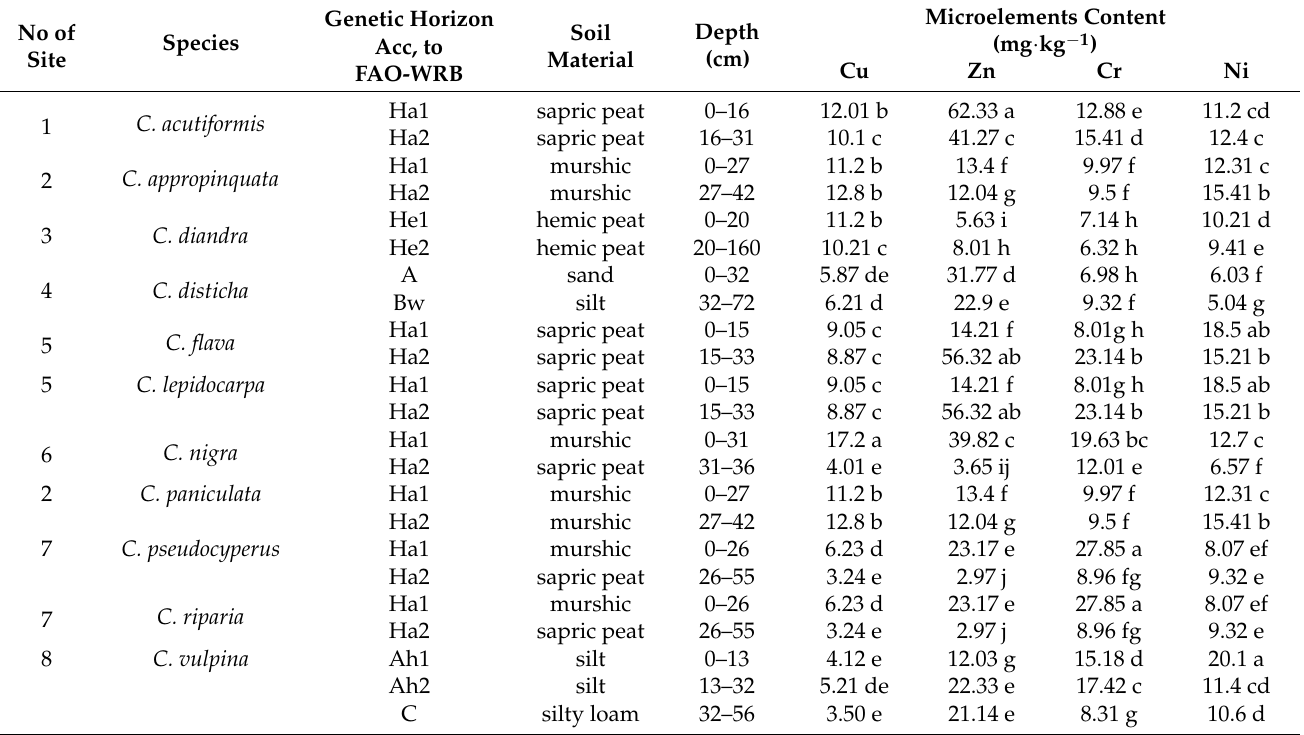
Table 3. Total content of microelements in the examined soils. The same letters indicate a lack of statistically significant differences among species analysed according to Tukey’s tests.